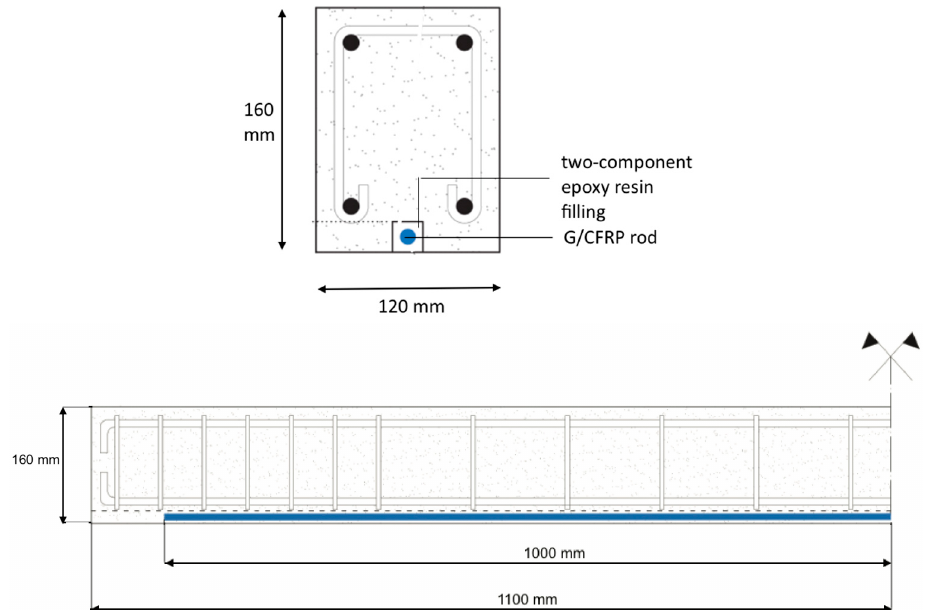
Figure 1. Geometric dimensions of RC beams with steel reinforcement and NSM rod.